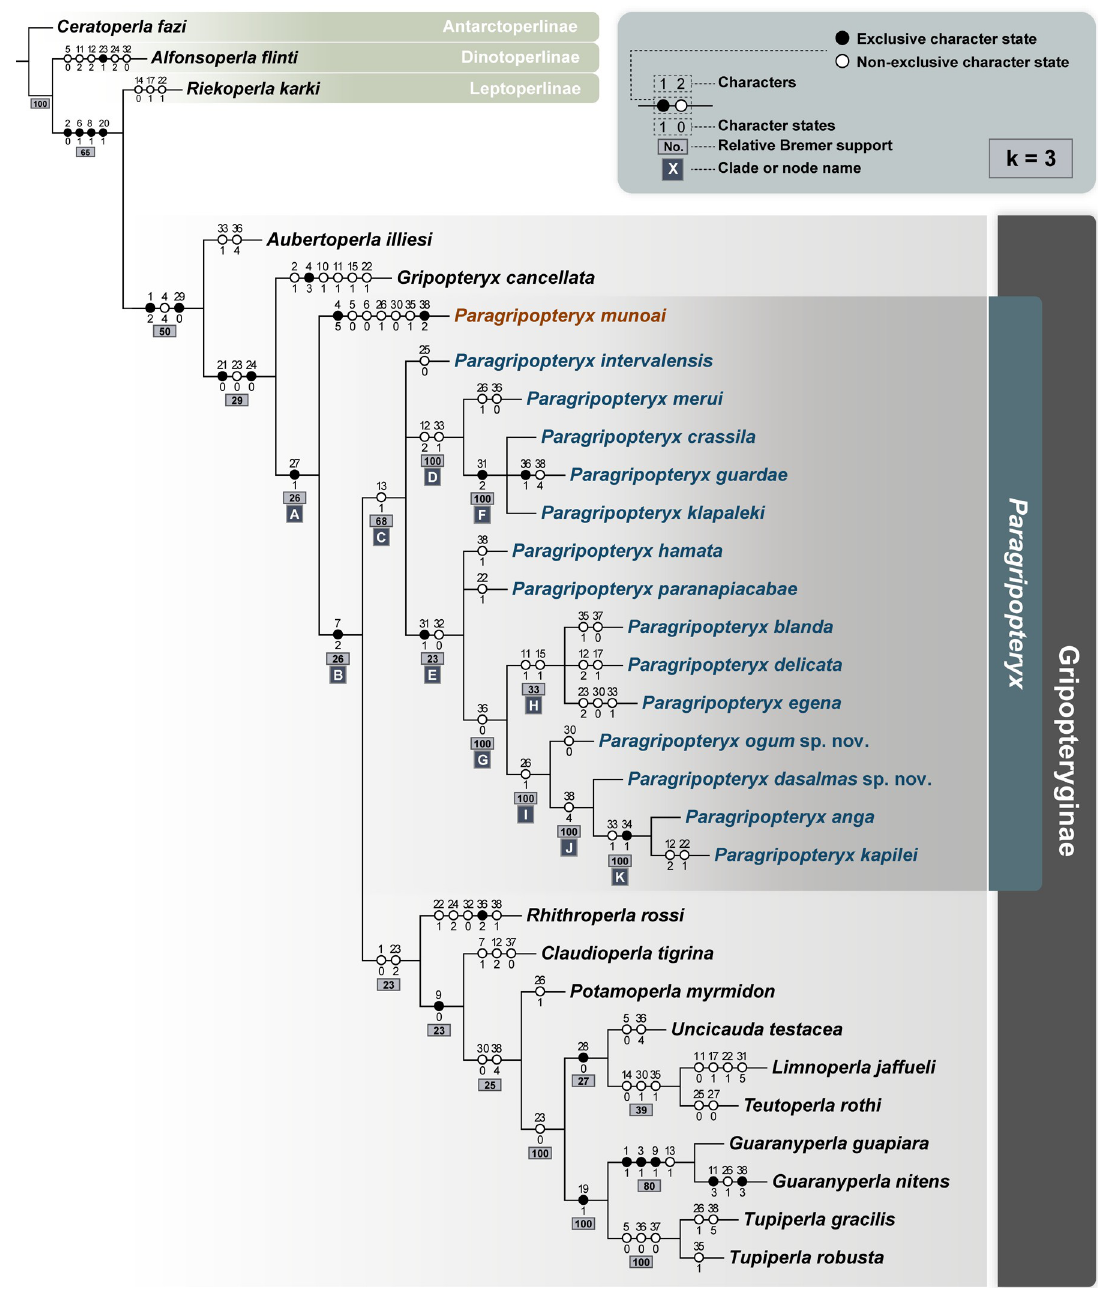
Fig 2. Phylogenetic hypotheses of Paragripopteryx . Analysis under IW scheme (k = 3); most Paragripopteryx (written in blue) are nested in a clade, except for P . munoai (written in red). synapomorphy supports Clade B: the ventral face of the third tarsal segment in nymphs pro- vided with small thin setae (character 7(2)). Inside Clade B emerges Clade C, which is sup- ported by only one synapomorphy (the presence of pterostigmatic crossveins in the forewings, character 13(1)) and encompasses all species of Paragripopteryx , except for P . munoai (Fig 2).